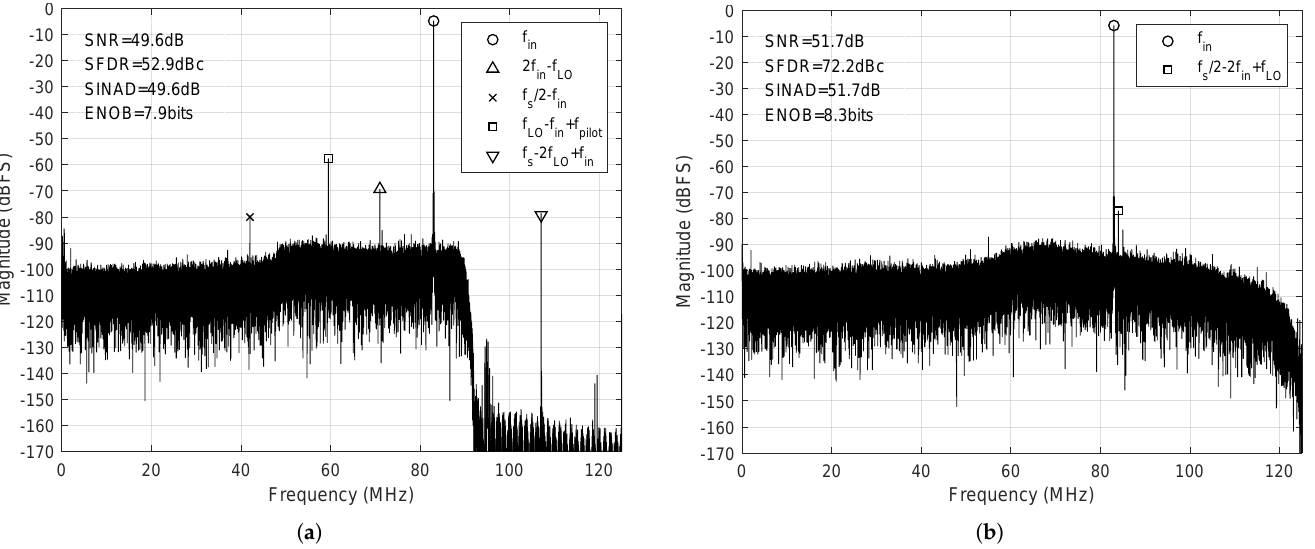
Figure 14. Single tone test spectrum in high frequency band: ( a ) 83 MHz input signal for classical architecture; ( b ) 83 MHz input signal for synchronous mixing architecture.